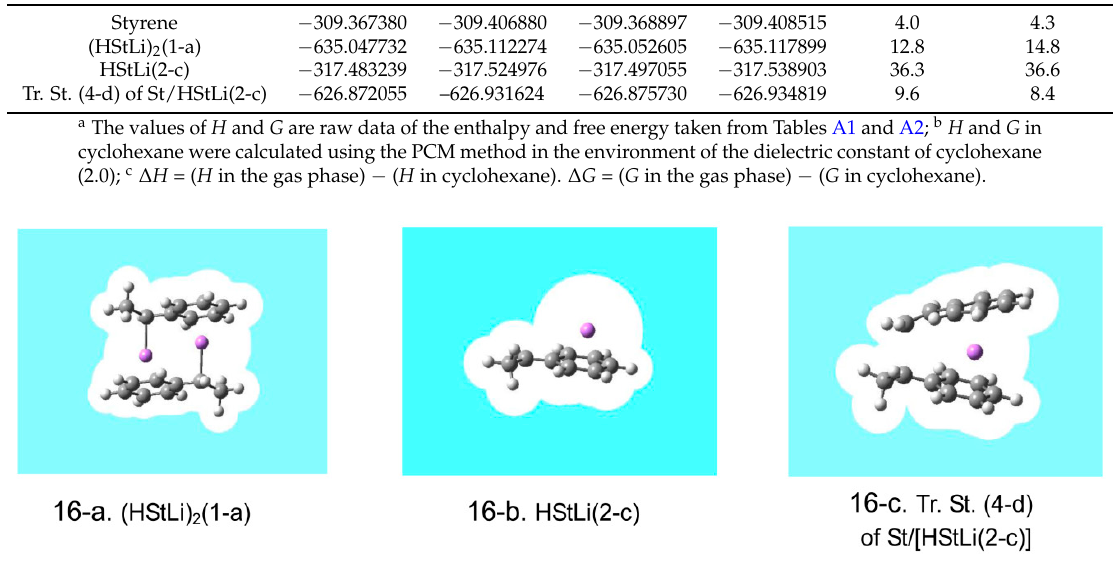
Figure 16. PCM models for the typical structures in solvent environment.